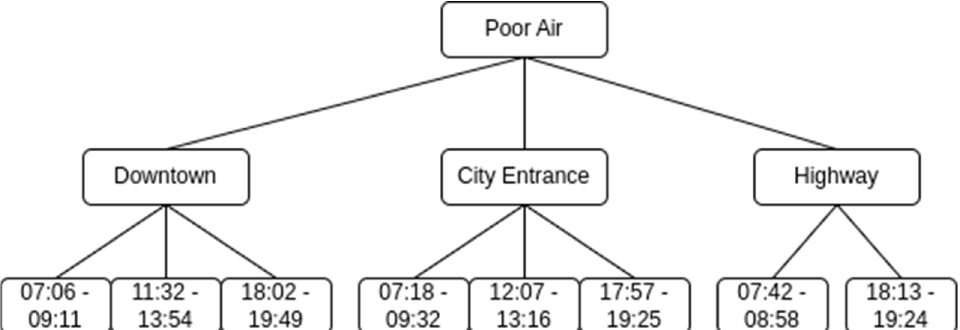
Figure 5. The decision tree generated in the machine learning process (using the C4.5 algorithm) shows patterns when the air quality is inadequate in each monitored location.